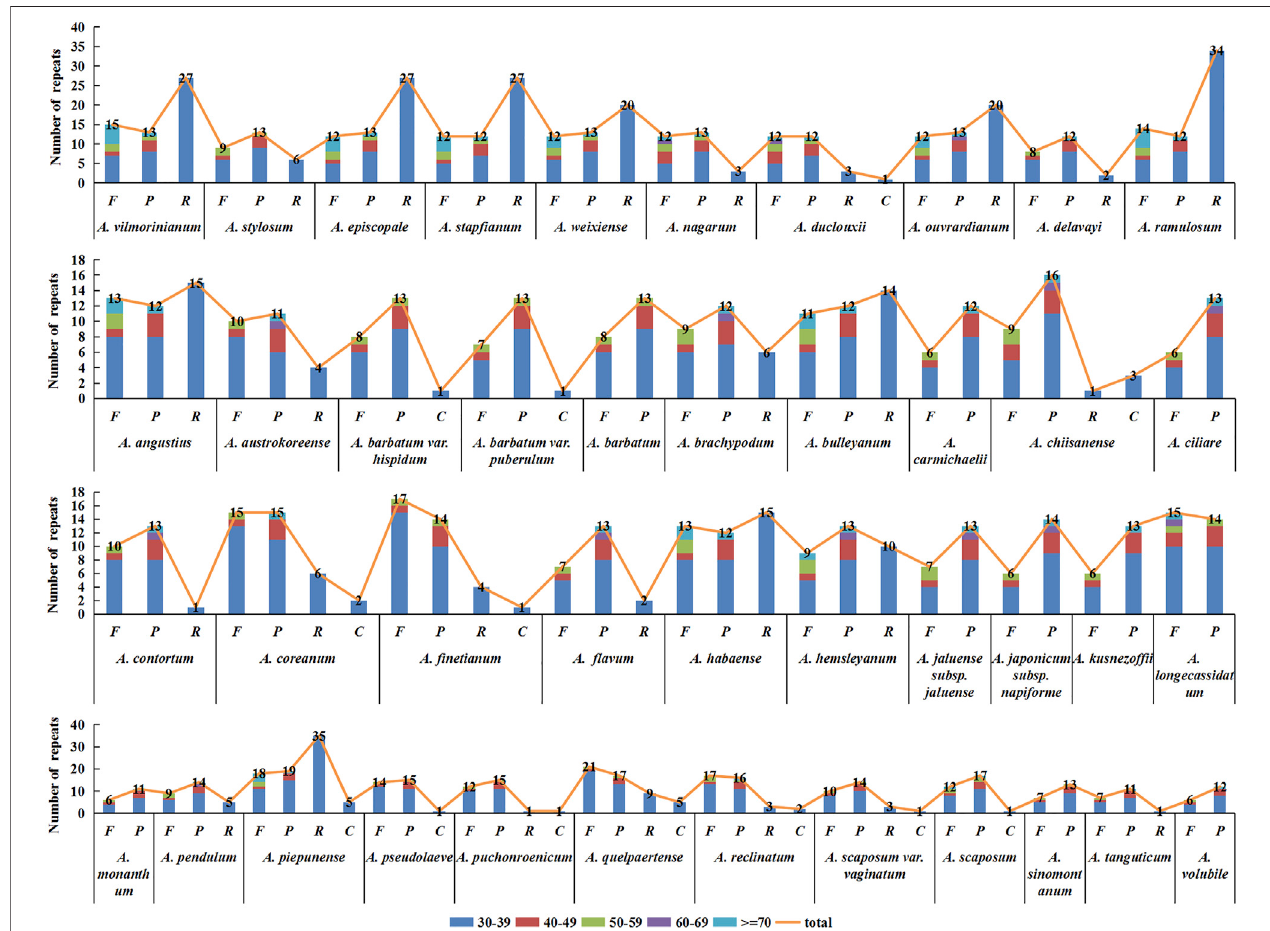
FIGURE 7 | Type and number of long repeat sequences distributed in the chloroplast genomes of 42 Aconitum species.